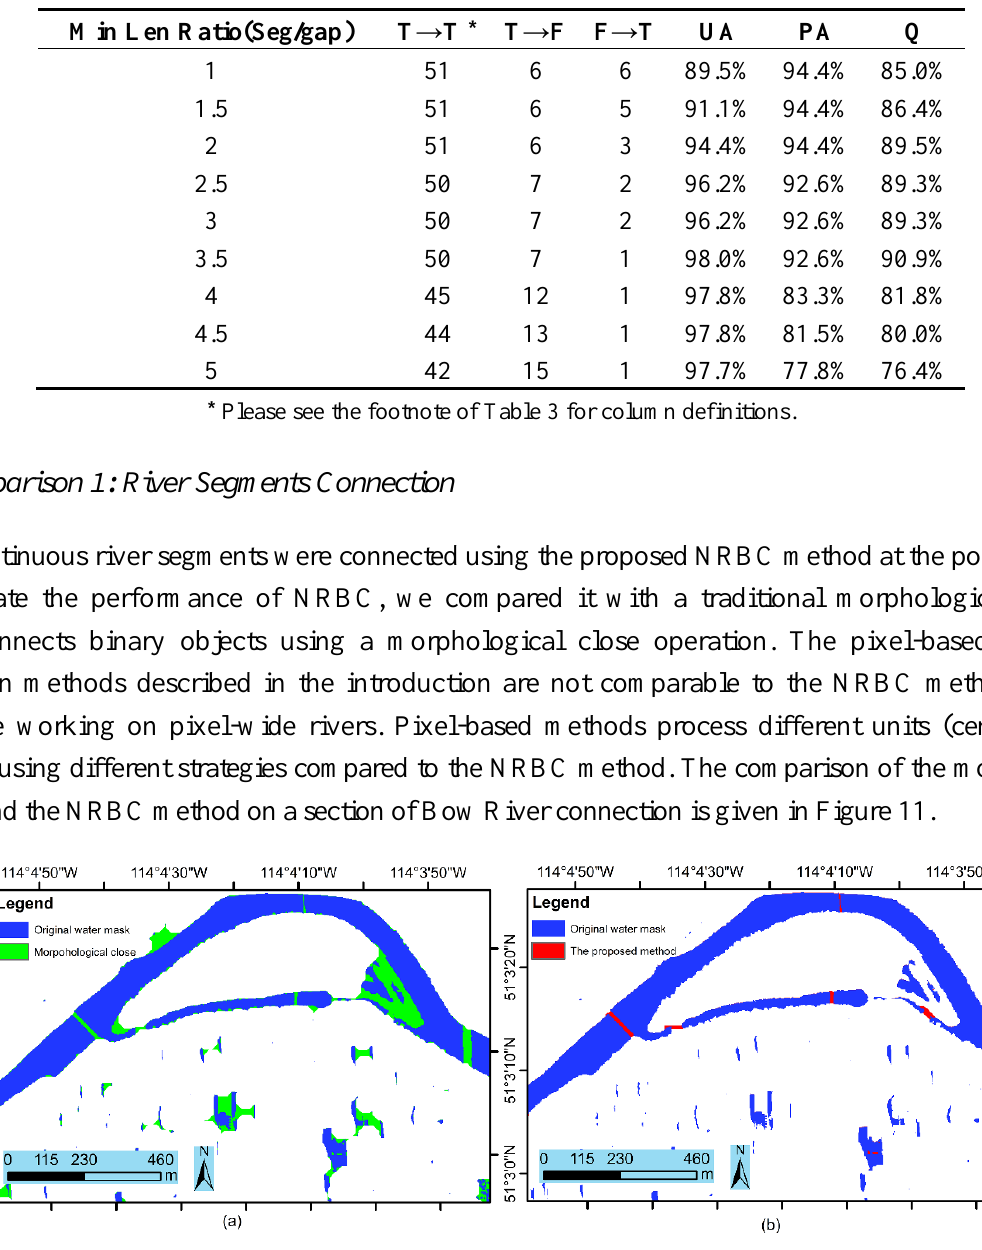
Table 6. The sensitivity of minimum segment length (T l ) in NRBC.